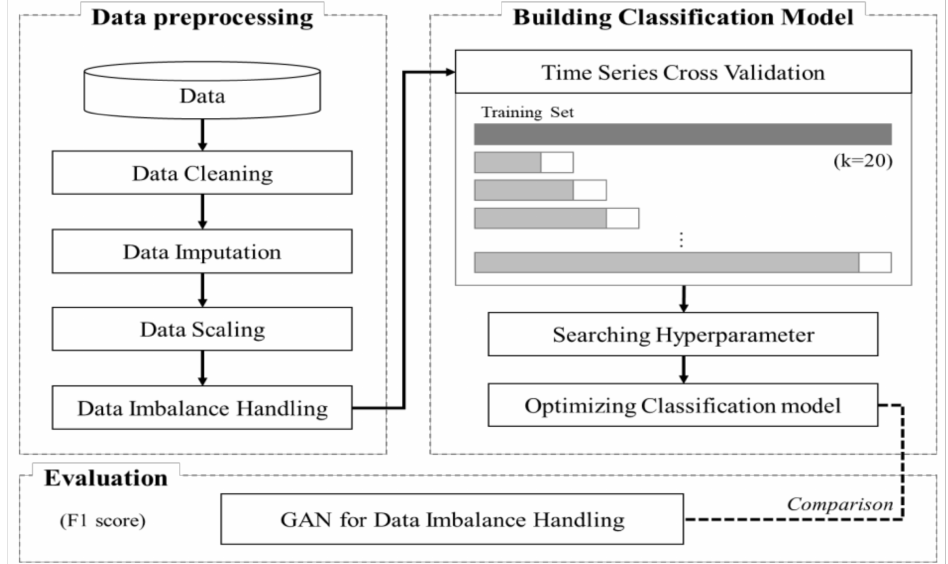
Figure 3. Framework for imputation and imbalance